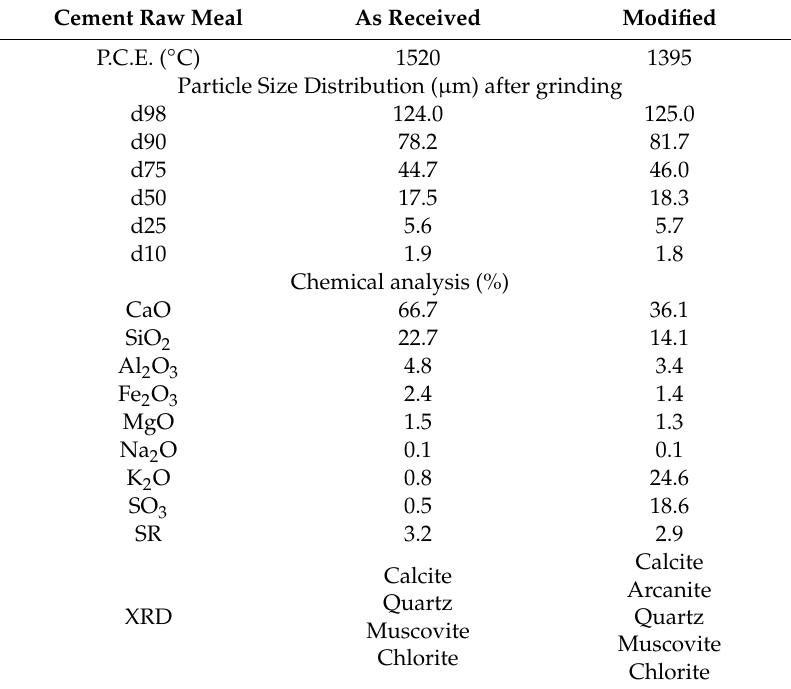
Table 3. Properties of cement raw meal used in the coating